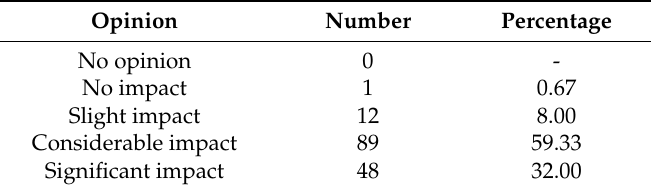
Table 4. Influences of readiness issue on the success of